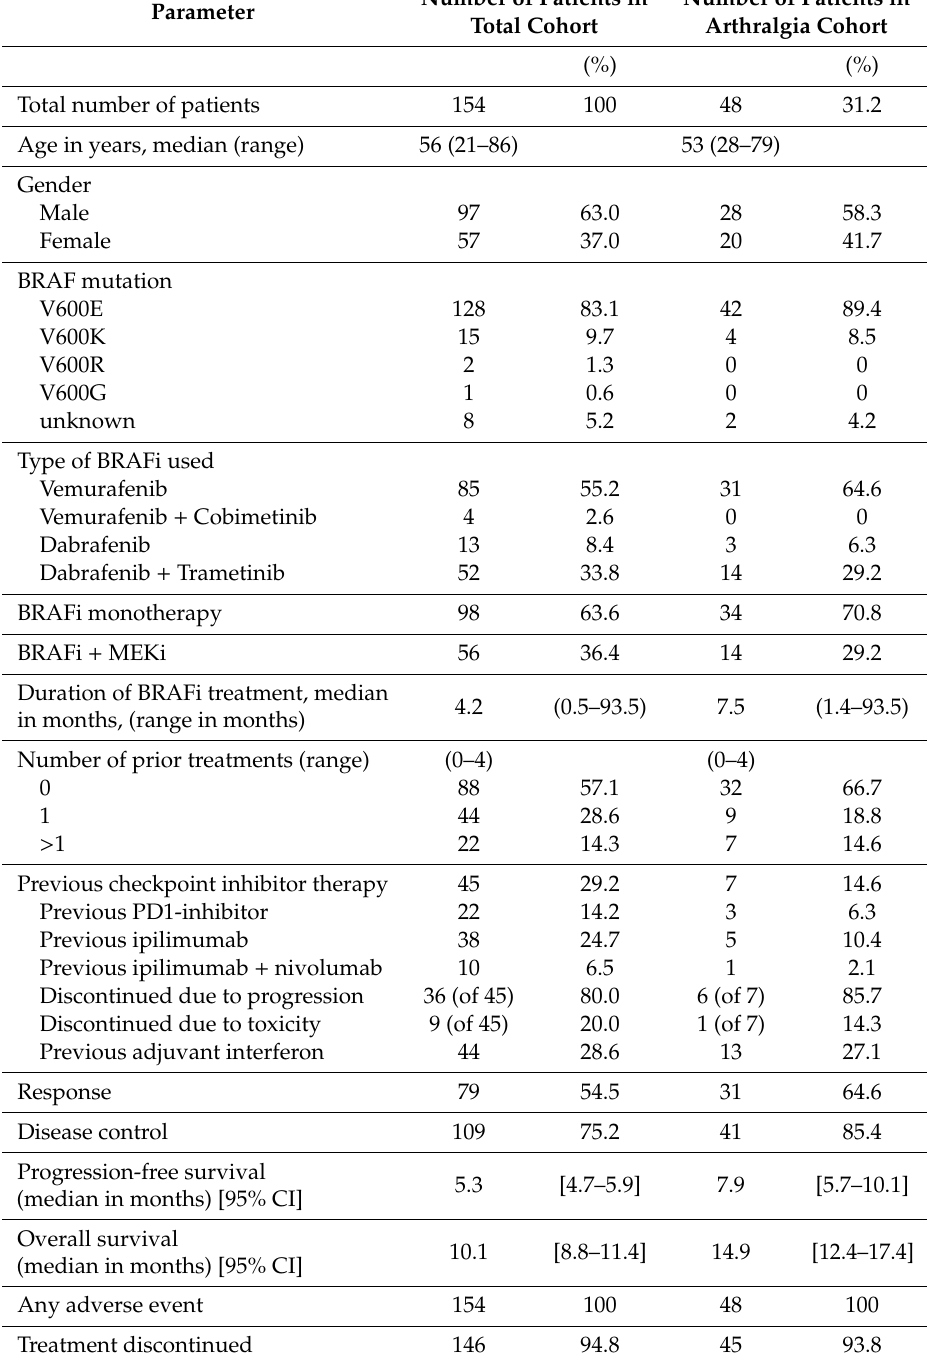
Table 2. Patient characteristics. MEKi, MEK